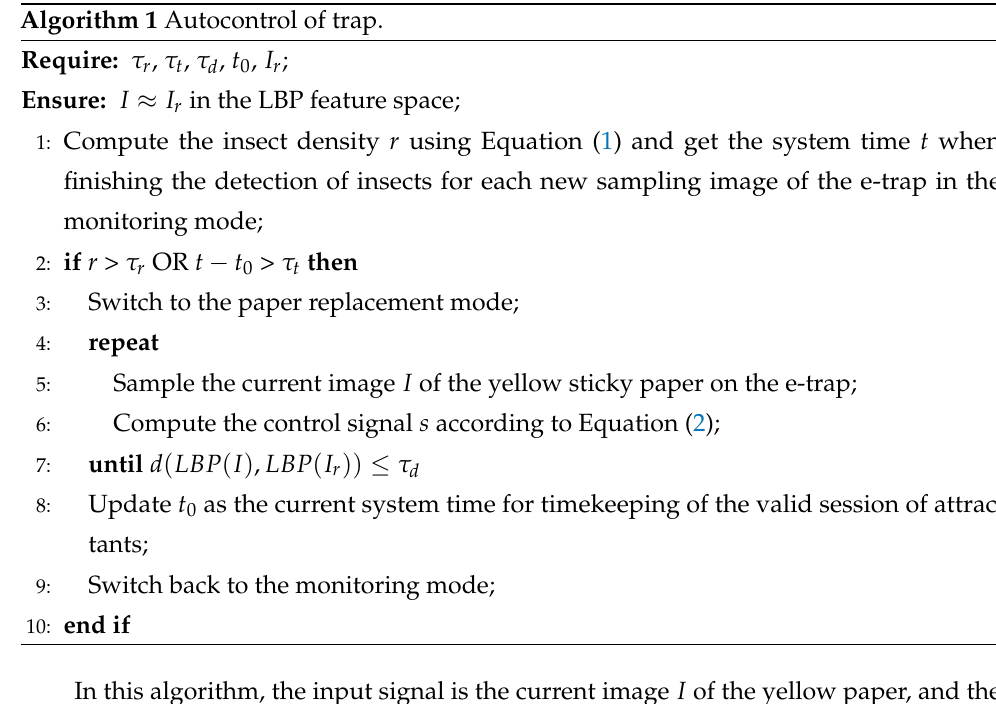
Algorithm 1 Autocontrol of